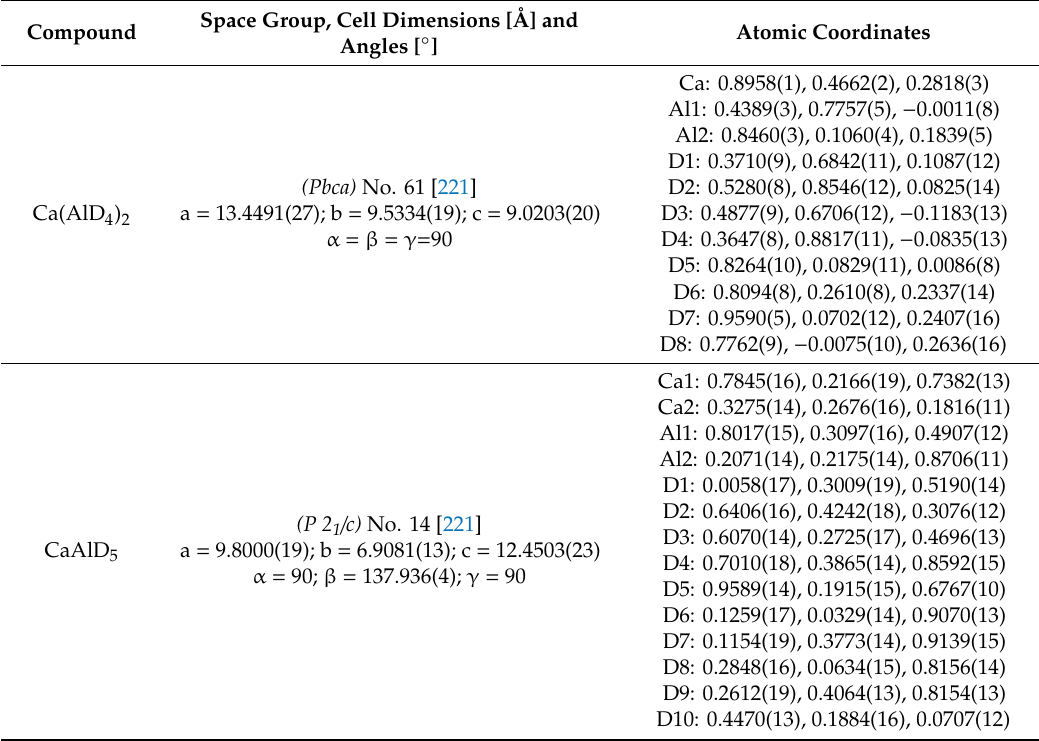
Table 9. Crystallographic data of calcium